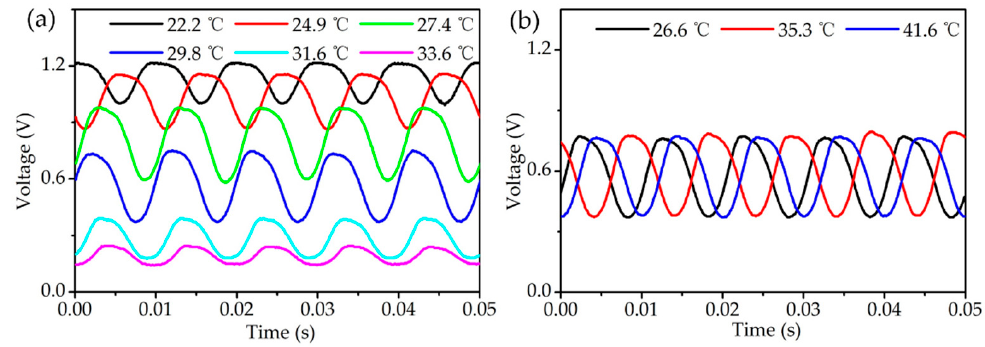
Figure 7. Signals at different temperatures without ( a ) and with ( b ) the PID control.